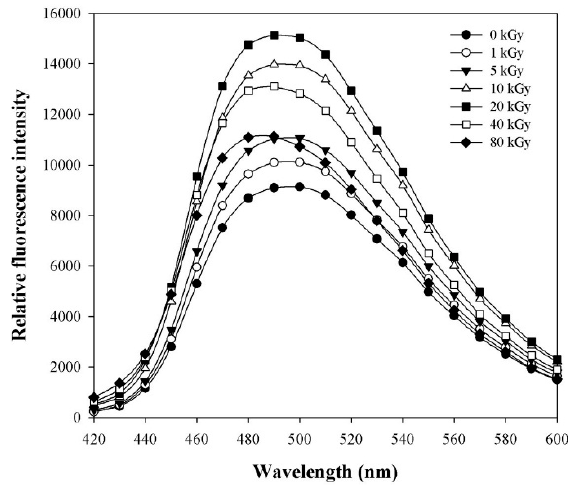
Figure 4. Change in hydrophobicity of AtTDX by γ -irradiation. Fluorescence spectra of bis-ANS bound to 100 μ g/mL of each irradiated AtTDX protein. The control was measured in the absence of AtTDX protein.